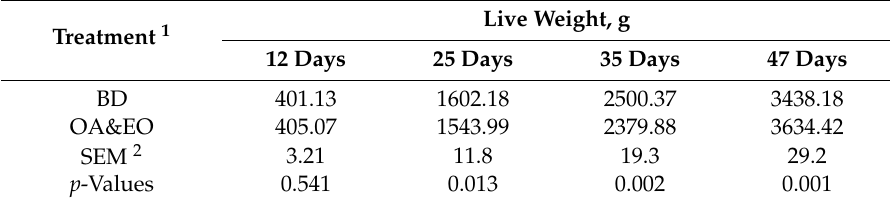
Table 3. E ff ects of dietary treatments on broiler live weight (n = 90 for